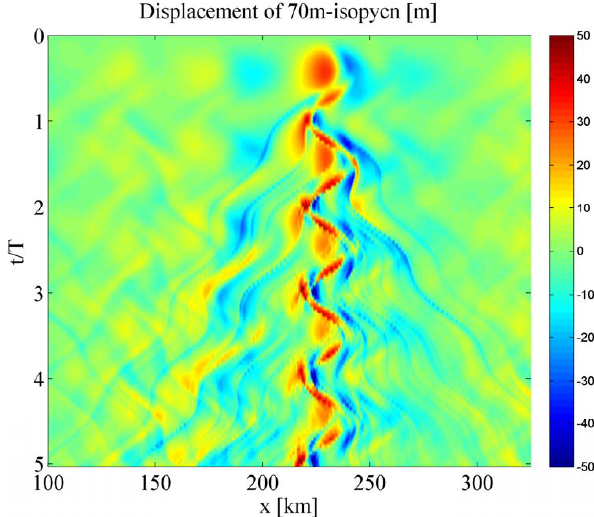
Figure 6 The Hovmuller plot for the displacement of the isopycn located at 70 m depth in the Fig. 6. The Hovmuller plot for the displacement of the isopycn located at 70m depth in the undisturbed undisturbed state.